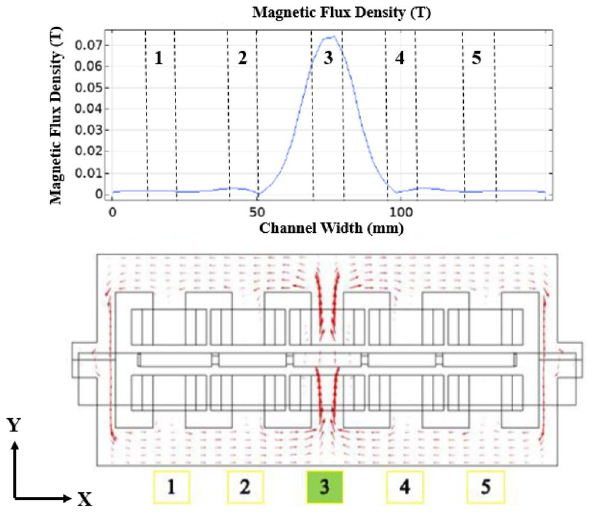
Fig. 11 The profile of the pressure variations in the simulation in longitudinal direction